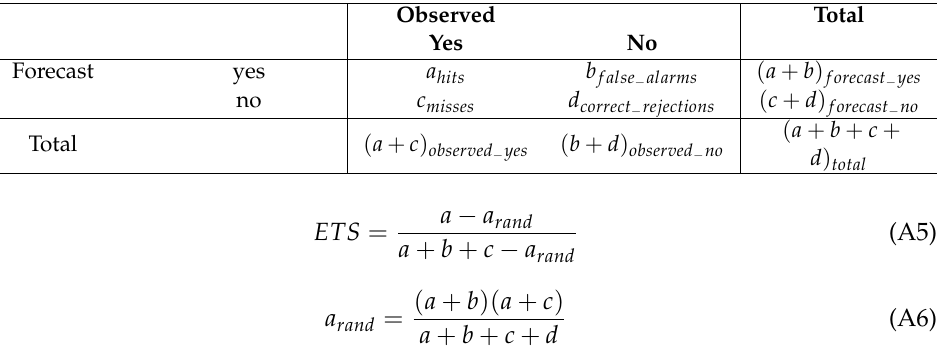
Table A1. 2 × 2 contingency table for precipitation